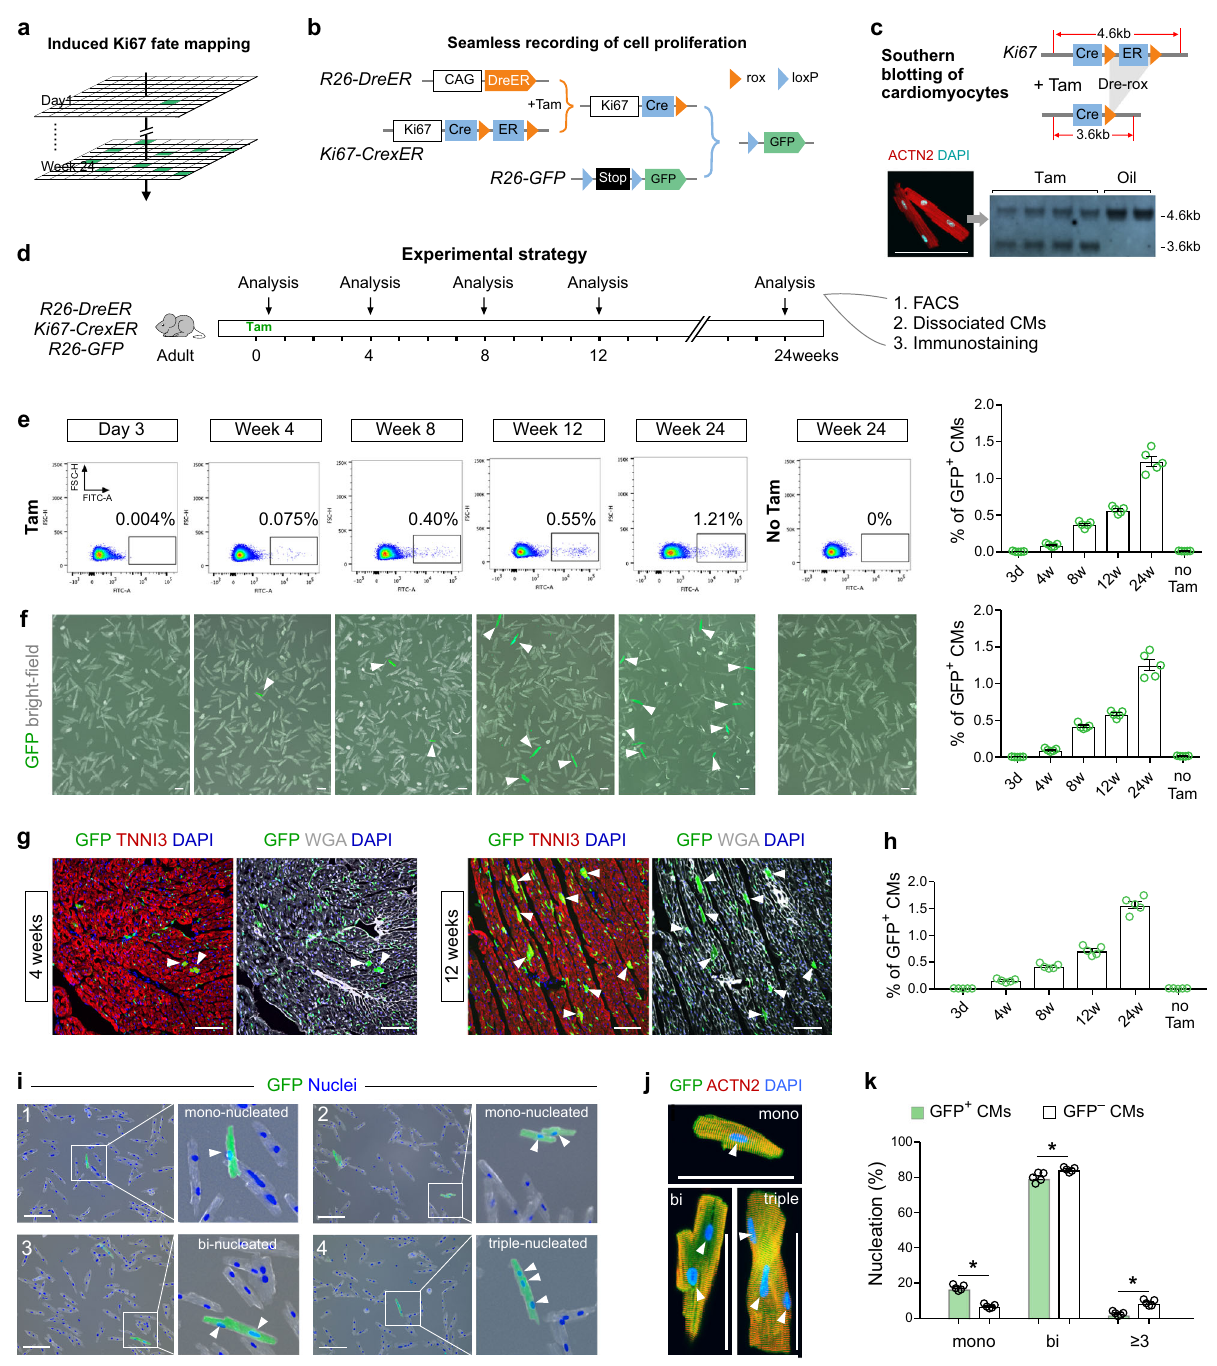
Fig. 1 Genetic tracing of cycling cardiomyocytes using ProTracer. a Schematic showing recording of Ki67 + cells (green) from Day 1 to Week 24 in mouse tissues. b Strategy for the seamless recording of cell proliferation. c Southern blotting of isolated cardiomyocyte DNA from Tam or corn oil-treated ProTracer mice. d Schematic of the experimental design. e FACS analysis of GFP + CMs and quanti fi cation of the percentage of GFP + CMs (on right). Data are the mean ± s.e.m.; n = 5. f Images of dissociated CMs from mice at the indicated time points after tamoxifen treatment, and quanti fi cation of the percentage of CMs expressing GFP (on right). Arrowheads, GFP + CMs. Data are mean ± s.e.m.; n = 5. g Immunostaining for GFP, TNNI3, or WGA on heart sections prepared from ProTracer mice. Arrowheads, GFP + CMs. h Quanti fi cation of the percentage of CMs expressing GFP. Data are mean ± s.e.m.; n = 5. i Images of isolated CMs showing mononucleated, binucleated, or triple-nucleated GFP + CMs. Arrowheads, nuclei. j Immunostaining for GFP and ACTN2 on isolated GFP + CMs. Arrowheads, nuclei. k Quanti fi cation of the percentage of mono-, bi-, triple, or multiple nuclei-containing cells in GFP + or GFP – CMs. Data are the mean ± s.e.m.; n = 5; * P < 0.0001, * P = 0.0103, * P = 0.0001 individually using two-tailed unpaired t-test. Scale bars, 100 µ m. Each image is representative of fi ve individual biological